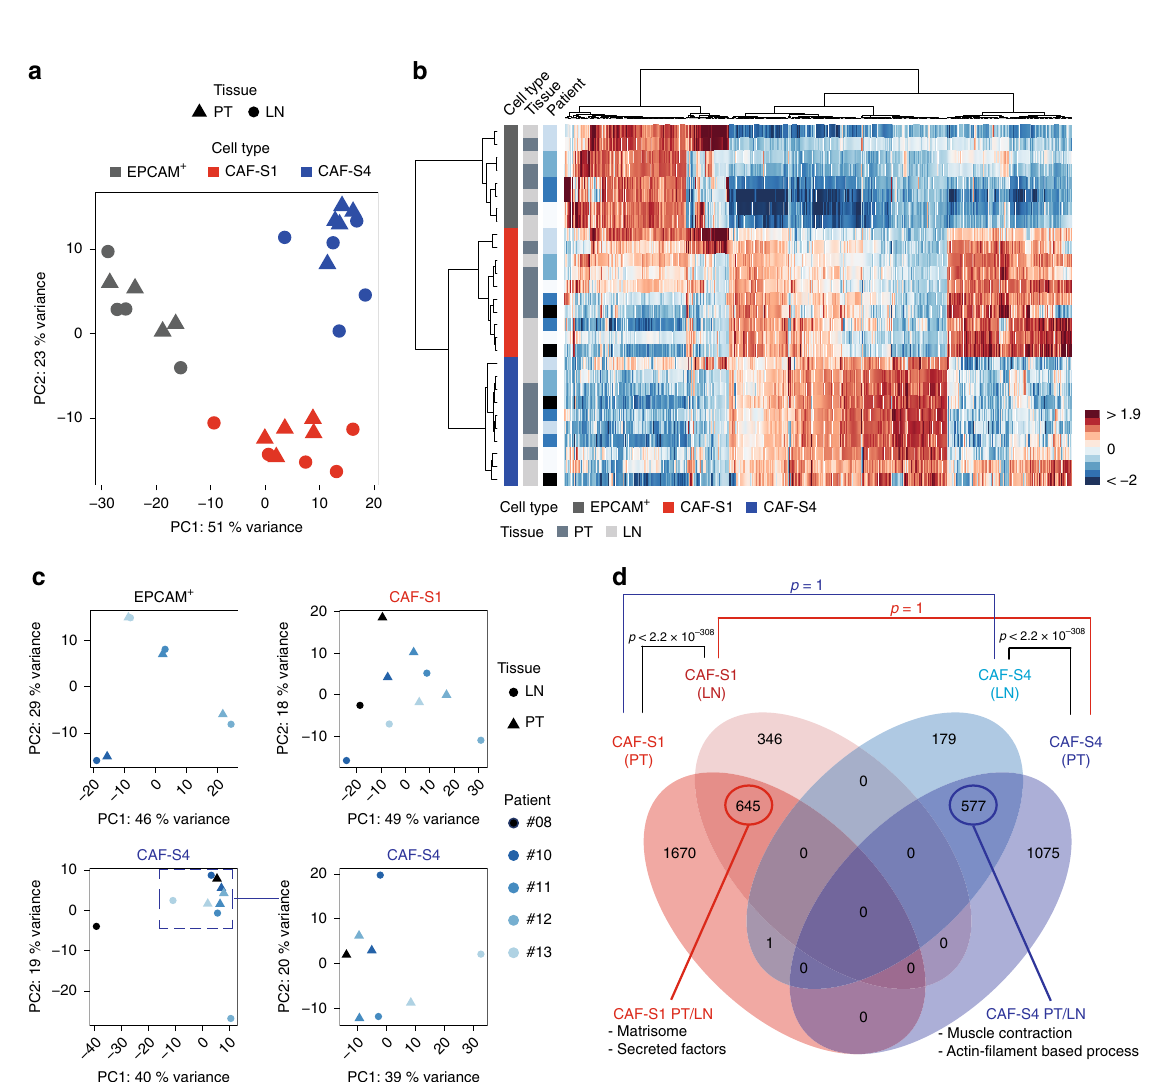
Fig. 2 Metastatic LNs are enriched in CAF-S1 and CAF-S4. a Percentage (%) of stroma in invaded LN according to BC subtypes ( n = 124), LumA (violet), LumB (blue), HER2 (light gray), Lum B/HER2 (dark gray), TN (black). b Histological scores (H-Scores) for each CAF marker in invaded LN according to BC subtypes ( n = 124). c Representative images of CAF marker staining on serial LN sections (LN#1 HER2; LN#2 TN). Scale bar, 50 μ m. d Decision tree de fi ning CAF subset identity based on quartile (Q) and median (Mdn) distribution of CAF markers. Thresholds and decision rules were fi rst established on FACS data and next applied to IHC data. e Repartition of CAF subset enrichments (CAF-S1 (red), CAF-S2 (orange), CAF-S3 (green) and CAF-S4 (blue)) in LN according to BC subtypes ( n = 124). f Representative views of CAF marker immunostaining on serial LN sections used for building maps of CAF subsets at cellular scale using the decision tree algorithm, shown in d . CAF-S1 are in red, CAF-S4 in blue and epithelial cells in black. CAF-S1- and CAF-S4-enriched LNs are shown. Scale bar, 200 μ m. g Repartition of CAF subset enrichments in PTs and matched LNs ( n = 41 pairs). h Same as in g with unmatched samples (N + cases, n = 75 PT and 84 LN). i Same as in h according to BC subtypes (Lum A: n = 38 PTs, 30 LNs; HER2: n = 16 PTs, 26 LNs; TN: n = 21 PTs, 28 LNs). j Contingency table showing repartition of CAF subset enrichments in PTs and corresponding invaded LNs ( n = 41 pairs). In all panels, boxplots are median ± 25% – 75% quantiles, whisker values range 1.5 × IQR above 75th or below 25th percentiles. b p Values from Mann – Whitney test. e , g , h p Values from Fisher ’ s exact test. Non-signi fi cant p values are not mentioned. Source data provided in Source Data fi le, with R scripts used.